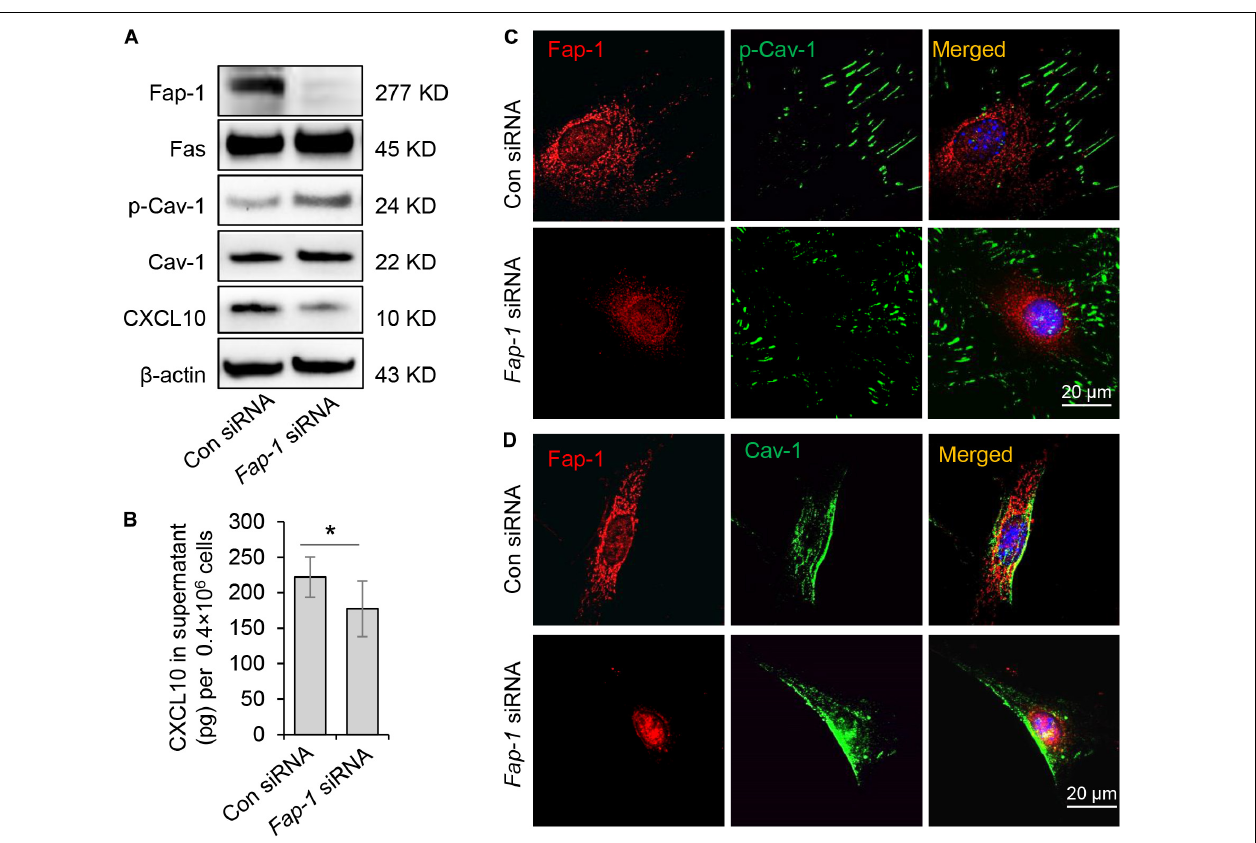
FIGURE 5 | Fas-associated phosphatase-1 controlled dephosphorylation of Cav-1 and CXCL10 release in murine GMSCs. (A) Western blotting analysis was used to confirm the efficiency of Fap-1 siRNA, and knocking down of Fap-1 up-regulated p-Cav-1 expression but reduced cytoplasmic CXCL10. (B) ELISA analysis showed that knocking down of Fap-1 decreased CXCL10 secretion in the culture supernatant of GMSCs. * P < 0.05. (C) Immunocytofluorescence staining images of p-Cav-1 (green) and Fap-1 (red) in WT control and Fap-1 deficient GMSCs. Scale bar, 20 µ m. (D) Immunocytofluorescence staining images of Cav-1 (green) and Fap-1 (red) in WT control and Fap-1 deficient GMSCs. Scale bar, 20 µ m. All results are representative of data generated in at least three independent experiments. Error bars are means ± SD. Data were analyzed using independent unpaired two-tailed Student’s t